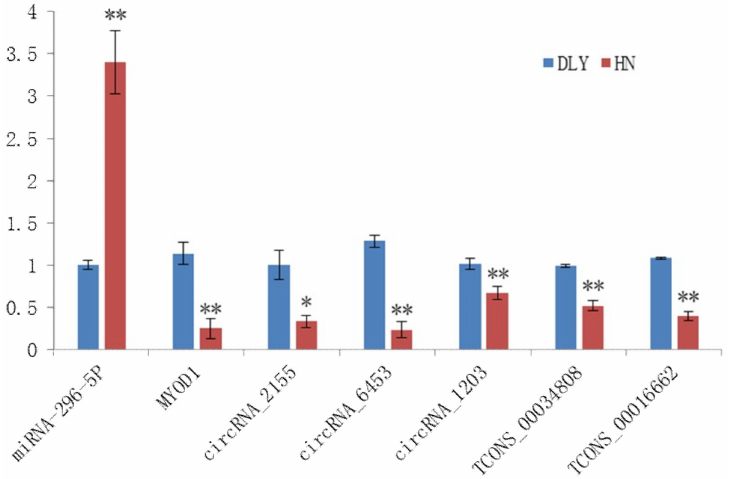
Figure 5. Validation of the expression of the MYOD1 -related ceRNA network (miRNA-296-5p, circRNA_2155, circRNA_6453, circRNA_1203, TCONS_00034808, and TCONS_00016662) by qRT-PCR. Note: The GAPDH and U6 were used as reference genes, the data represented the Mean ± SD from 3 biological replicates, and each measurement was repeated 3 times. The fold change from the qPCR was calculated using the 2 - (cid:52)(cid:52) Ct method. ** indicates p < 0.01, * indicates p <